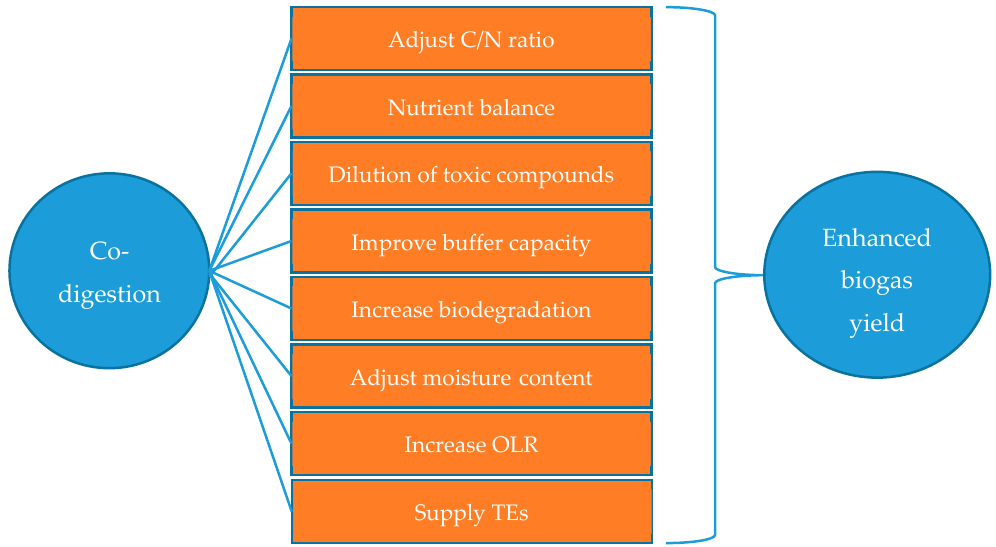
Figure 6. Advantages of anaerobic co-digestion [61–63].